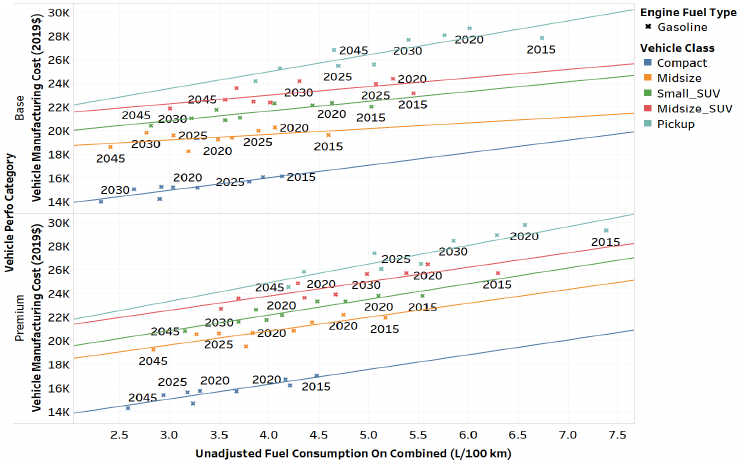
Figure 15. Manufacturing cost versus fuel consumption of split